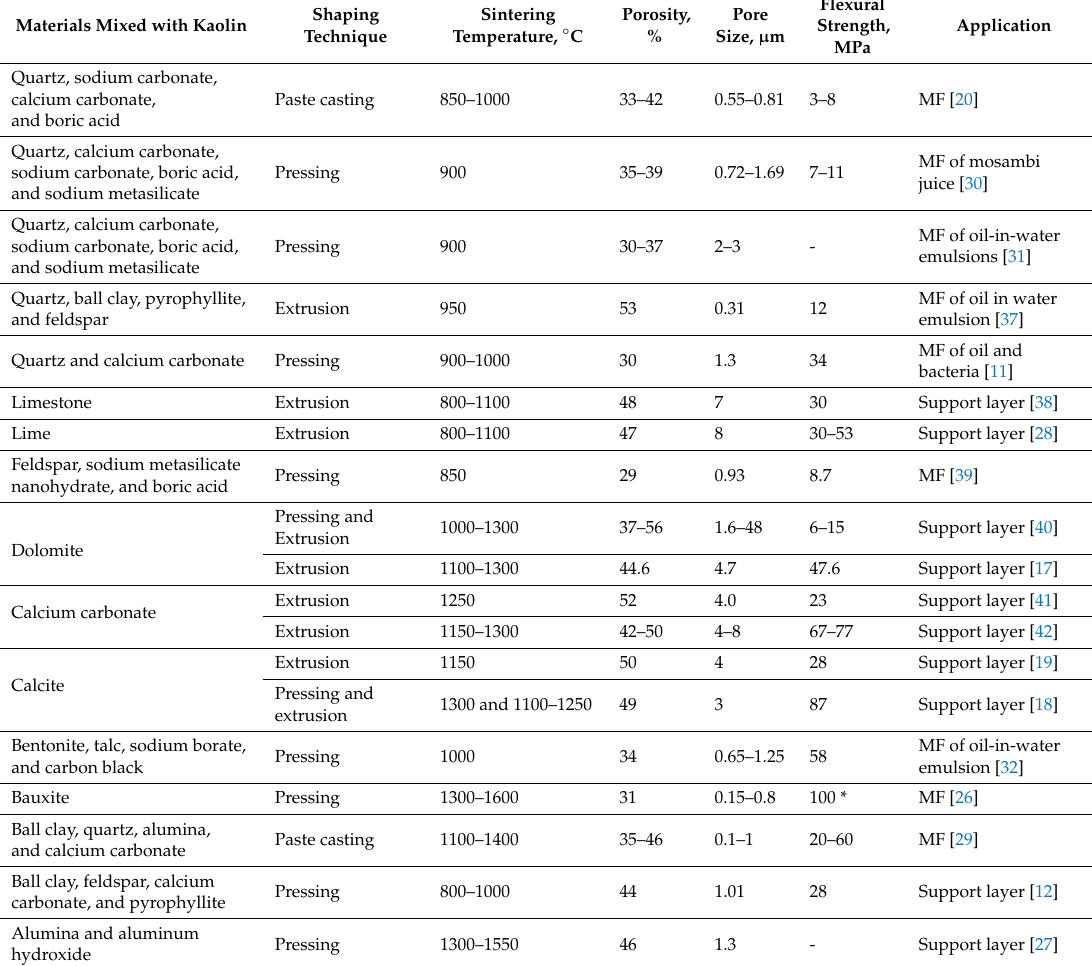
Table 1. Low-cost membranes prepared using kaolin as a main raw